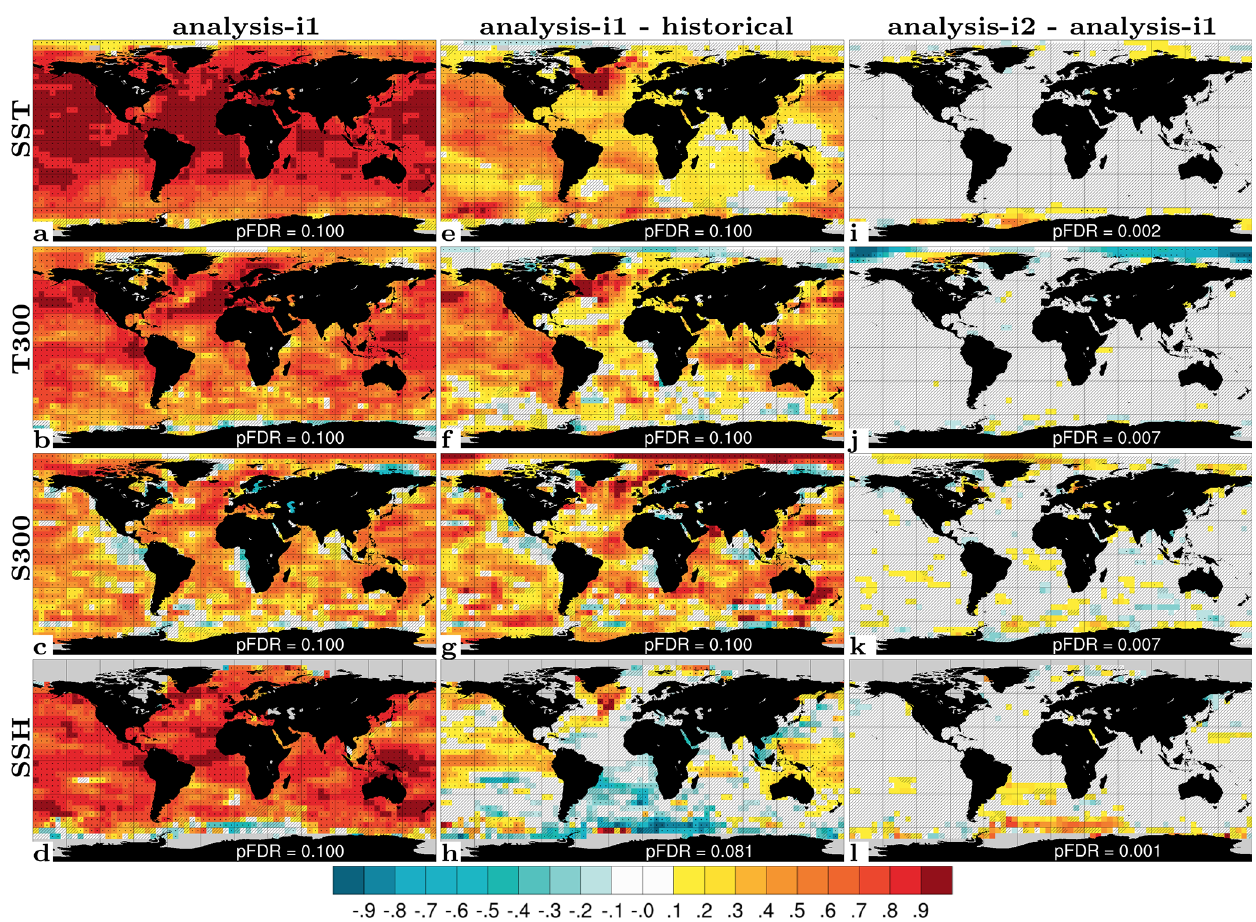
Figure 6. ACC for annual SST (a) , 0–300m temperature (b) , 0–300m salinity (c) and sea surface height (d) for assim-i1 . (cid:49) ACC for assim-i1 – historical (e–h) , assim-i2 – assim-i1 (i–l) . Temporal coverage is 1950–2018 for SST (ERSSTv5; Huang et al., 2017) and temperature and salinity (EN4.2.1; Good et al., 2013) observations, and 1993–2018 for sea surface height (ARMOR-3D; Larnicol et al., 2006). Hatched areas are not locally significant; dotted areas are field